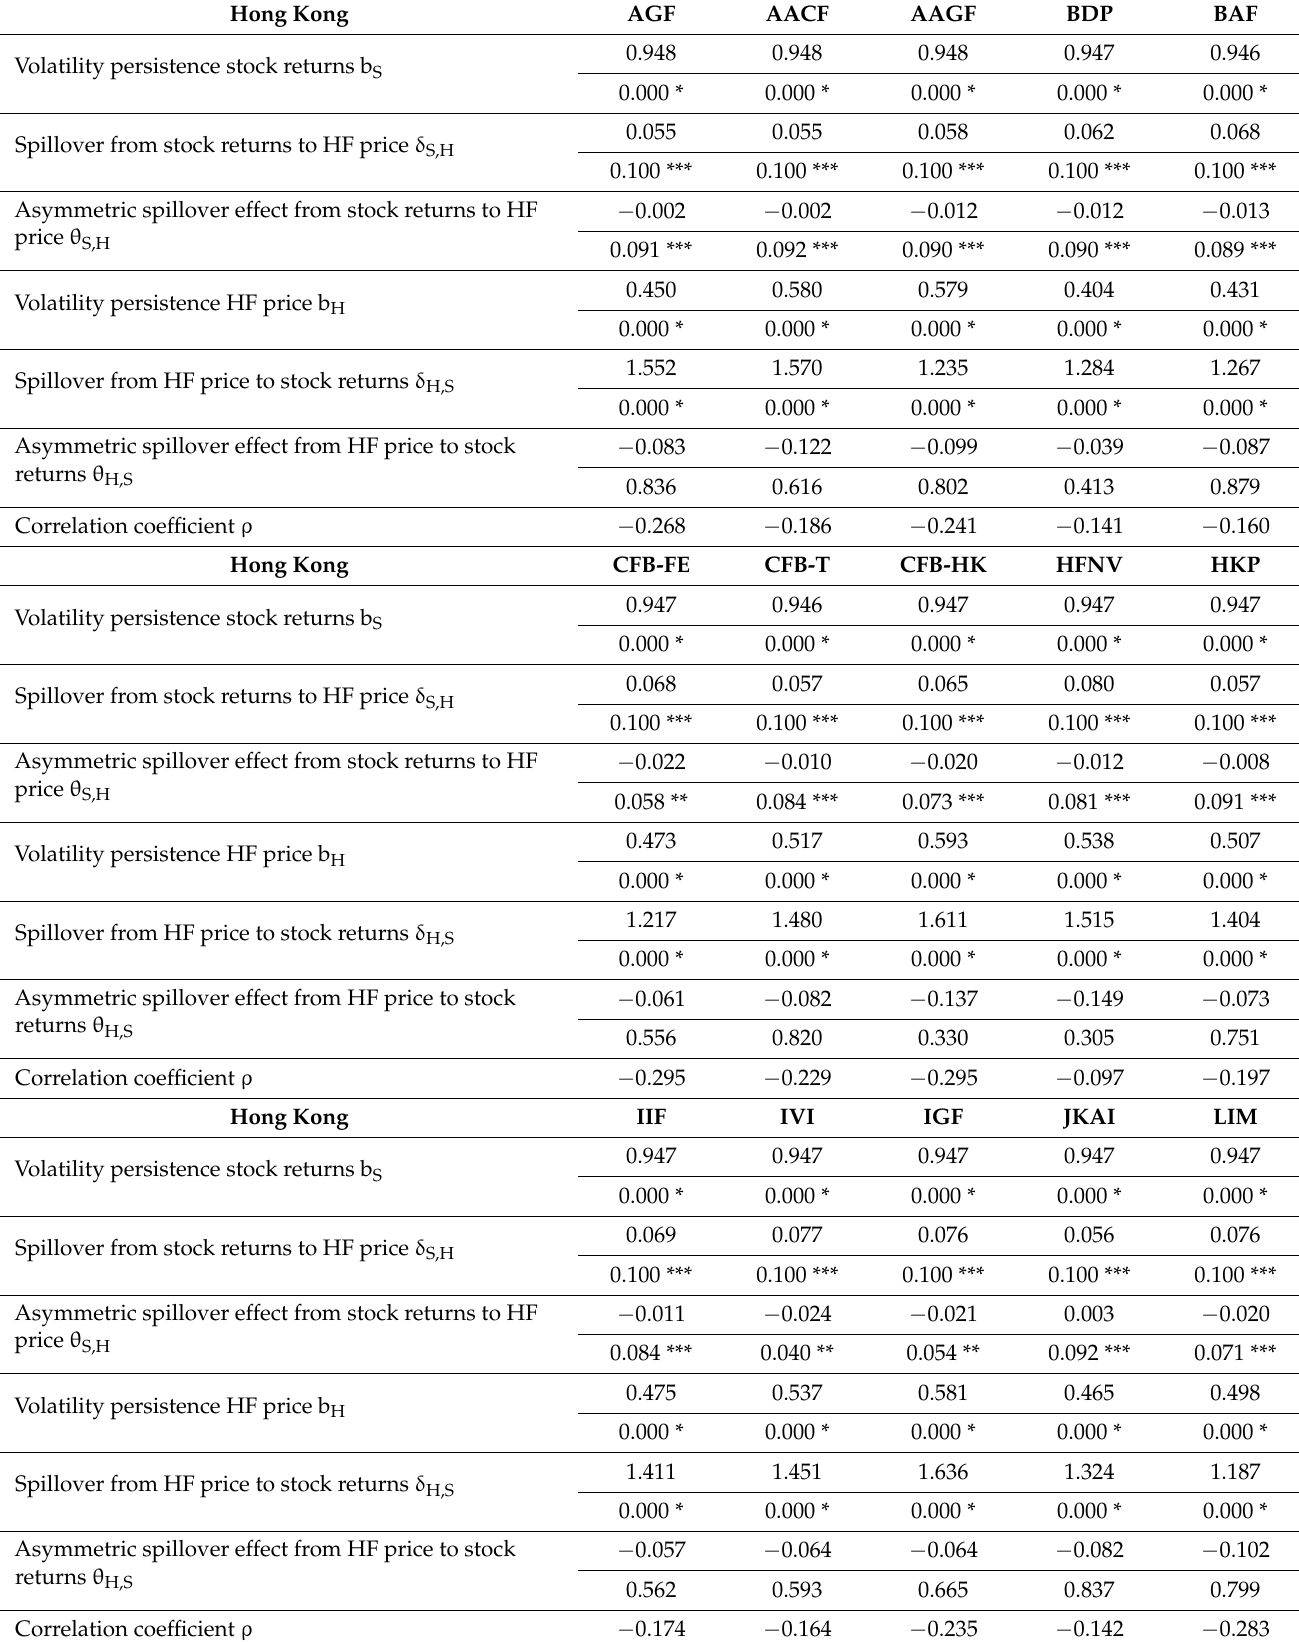
Table 9. Volatility spillover between the Hong Kong Stock Market (HSI) and Hedge Fund